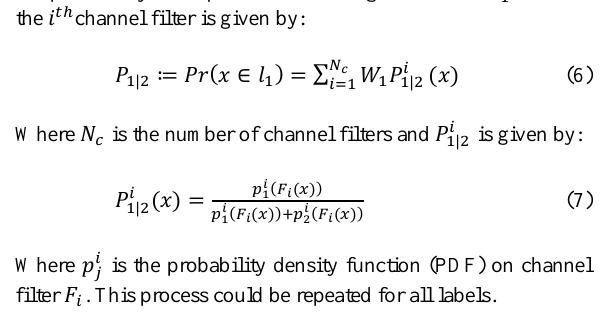
Table 2. Measurements used for polynomial derivation and comparison with experimental law